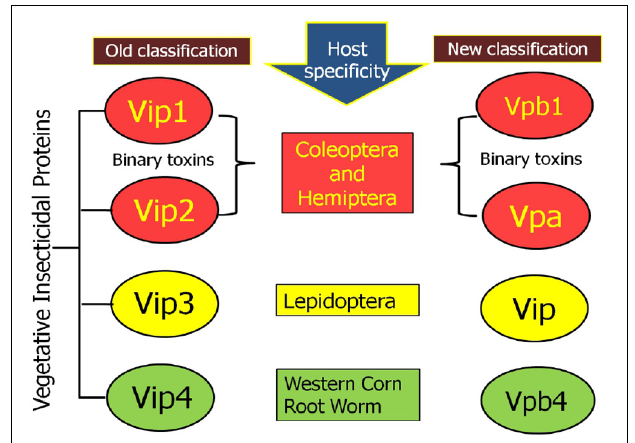
FIGURE 2 | Schematic representation of comparative changes in the old and new classification system for Vip family protein.